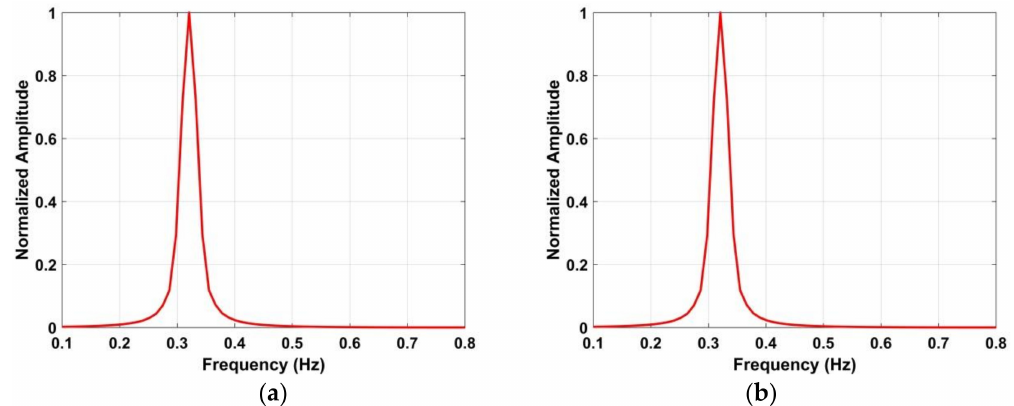
Figure 18. ( a ) Respiration signal spectrum and ( b ) area of interest obtained using the MHOC method.